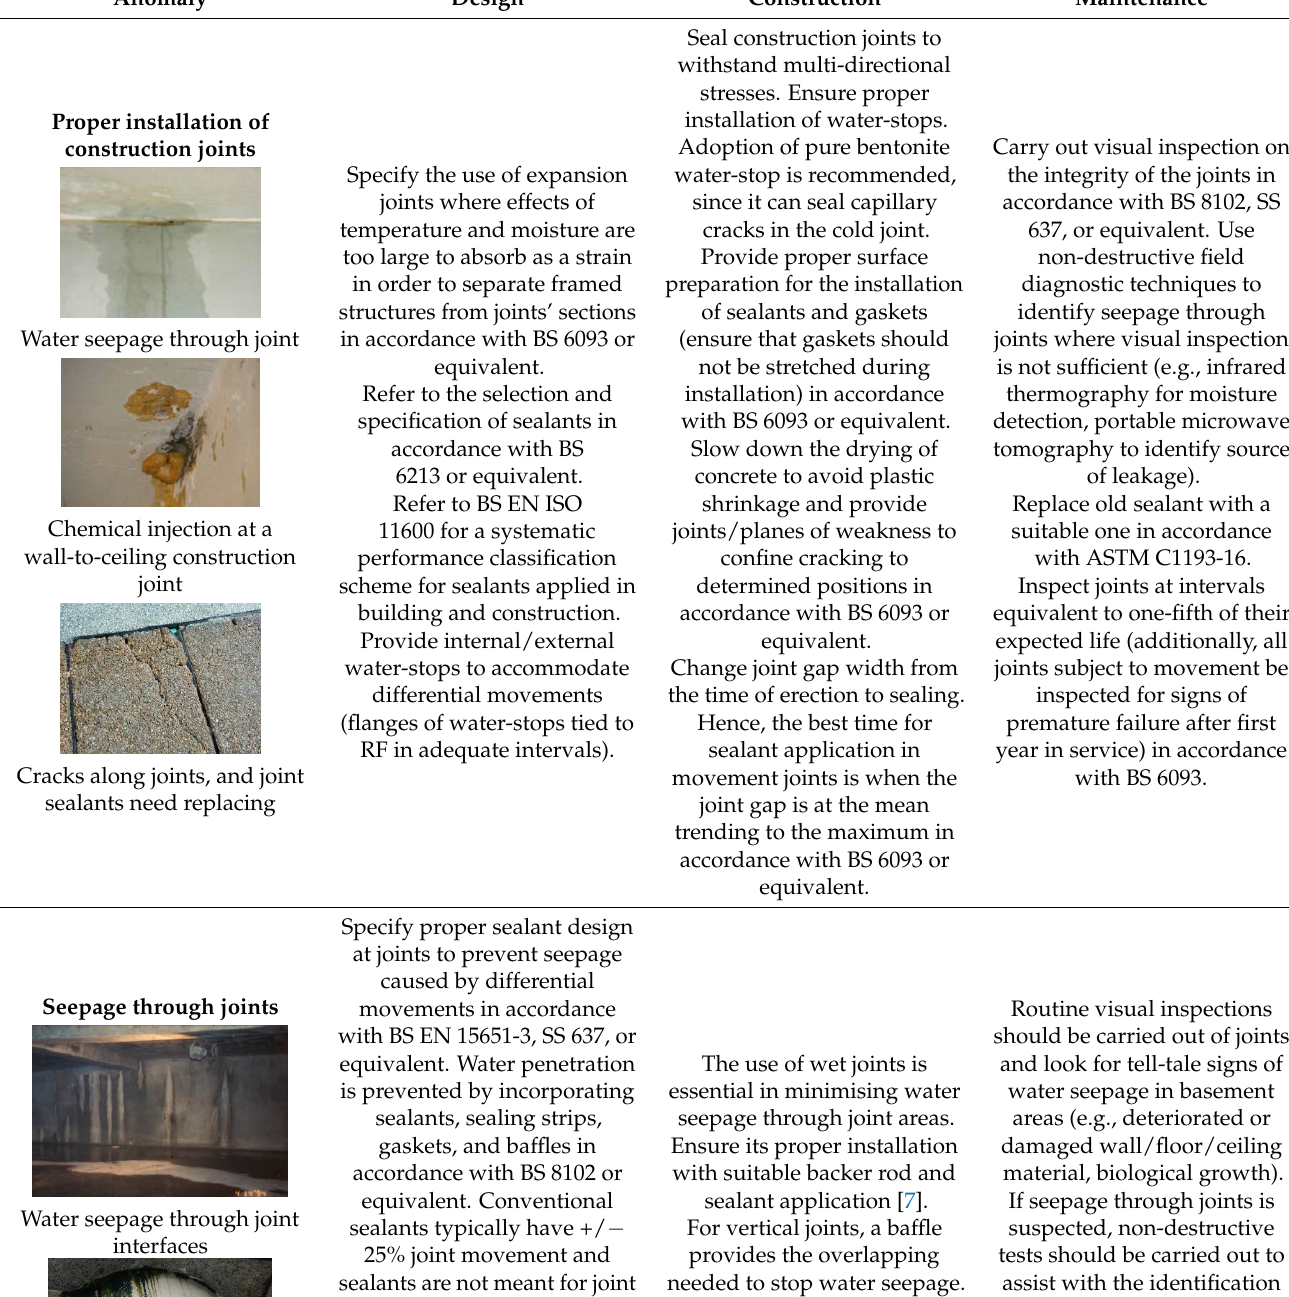
Table 3. Basements—Architectural components e.g., finishes, furnishings, and other elements that contribute to the aesthetic value and liveability.